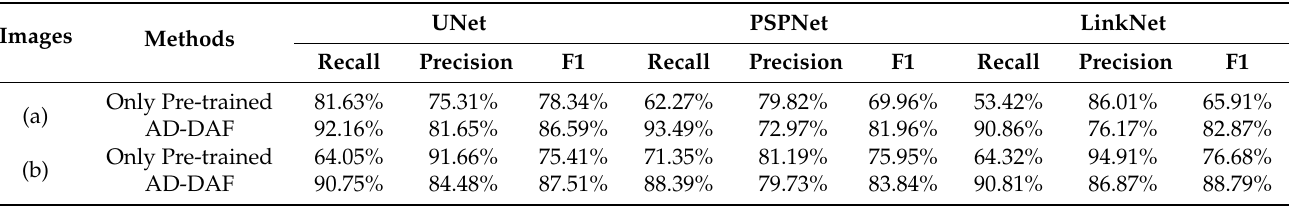
Table 1. The results on the three semantic segmentation models in two different target